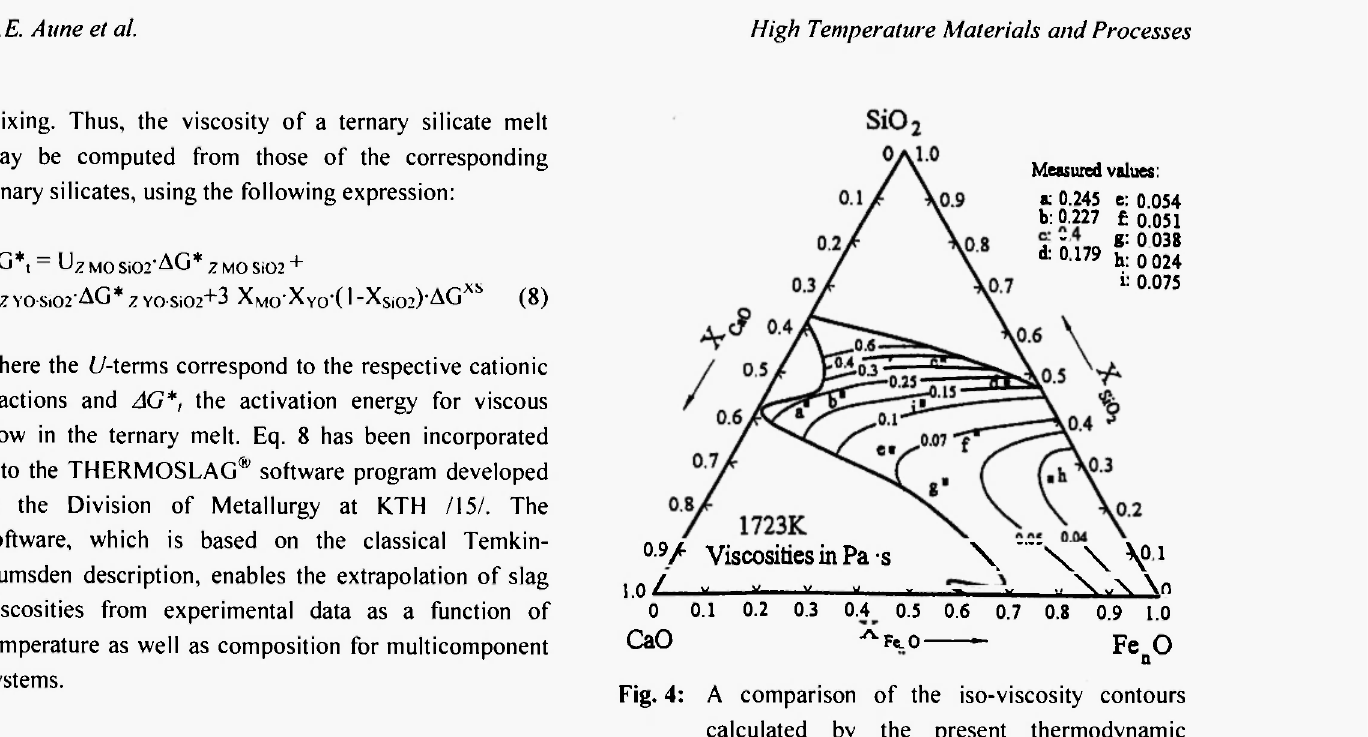
Fig. 4: A comparison of the iso-viscosity contours calculated by the present thermodynamic approach and the experimental data in the case of the system Ca0-Fe0-Si0 2 at 1723